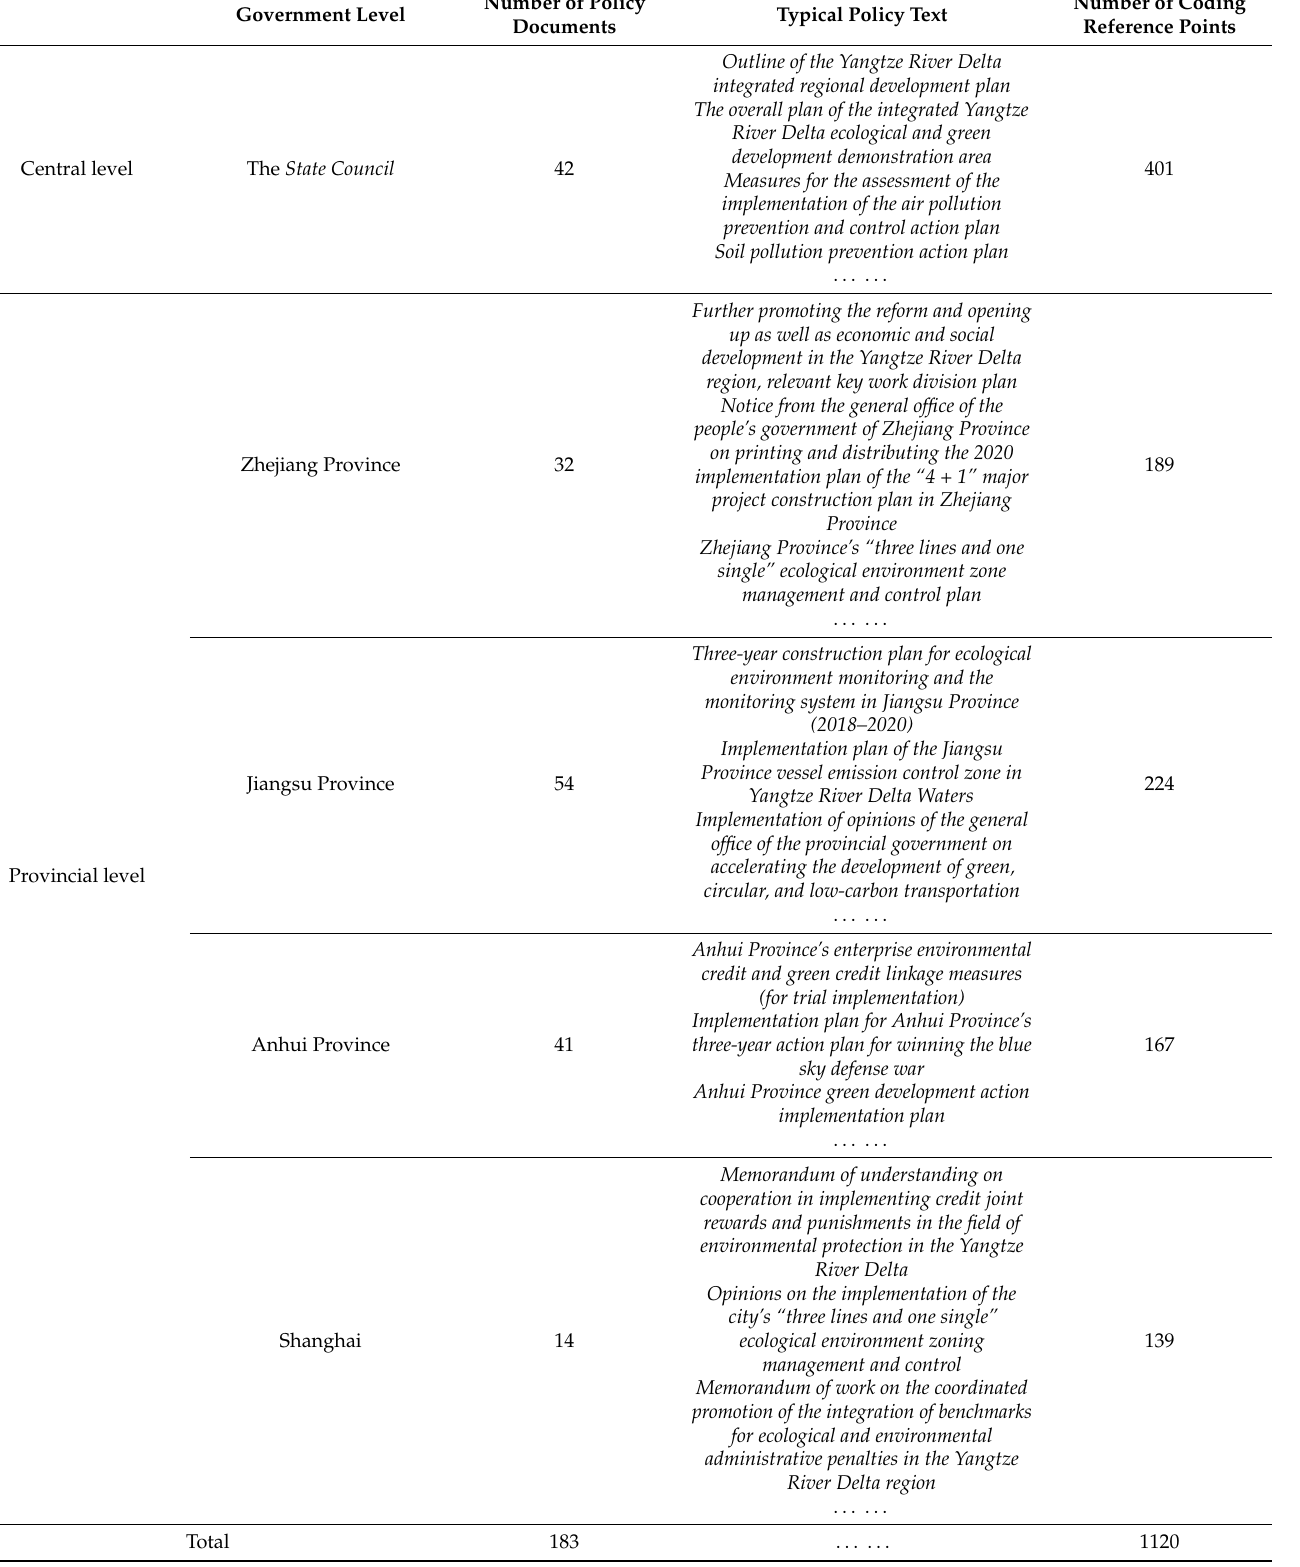
Table 1. Coding of policy texts at various government levels in the Yangtze River